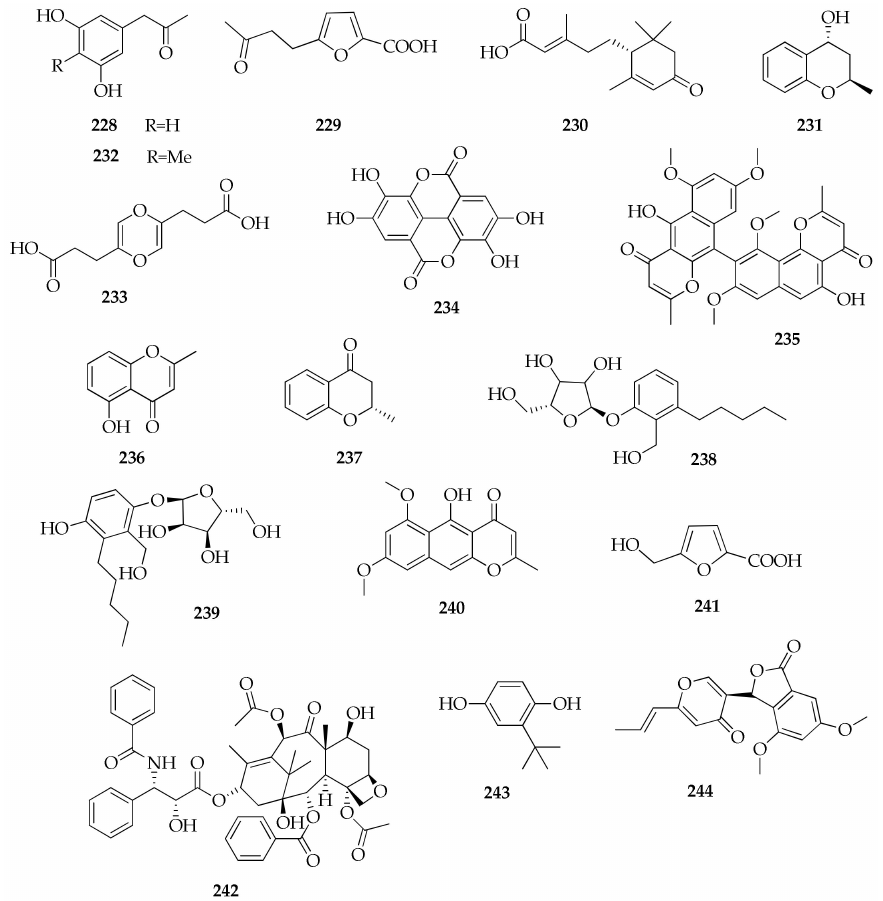
Figure 32. Structures of compounds from the group